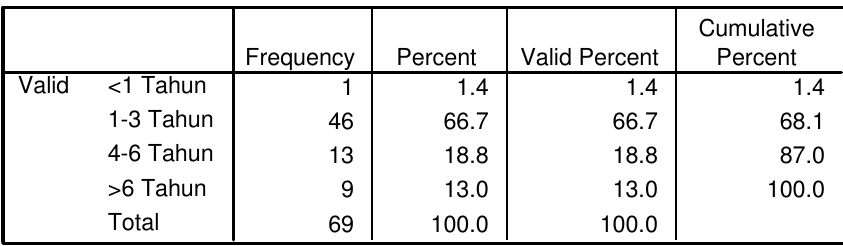
Tabel 4. Frekuensi Lama Investasi